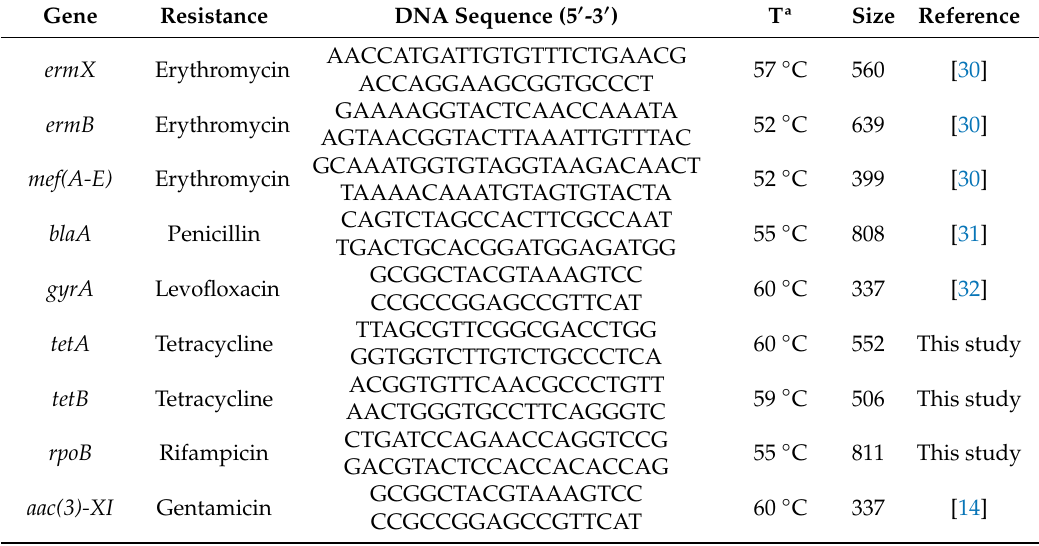
Table 4. Primers used in the detection and sequencing of resistance genes. Tª indicates annealing temperatures. Size refers amplicon sizes in base